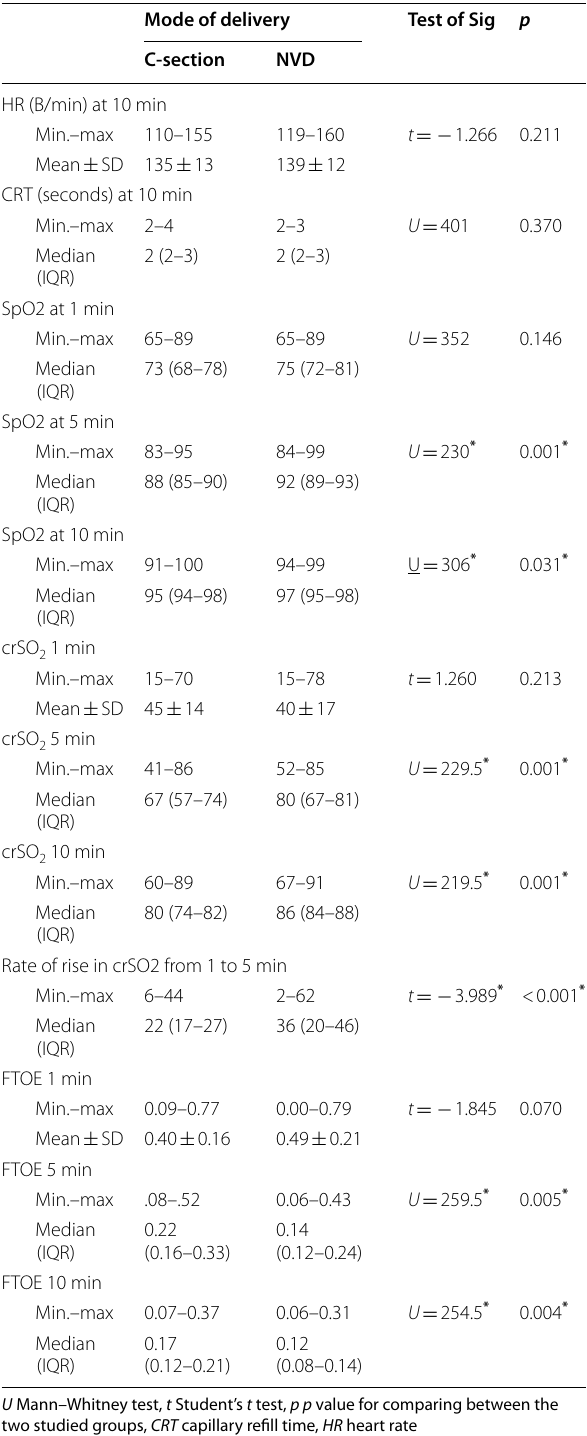
Table 6 Comparison between the two studied groups (C‑section and NVD) according to HR, CRT, cerebral oxygenation parameters (crSO2 and FTOE), and oxygen saturation